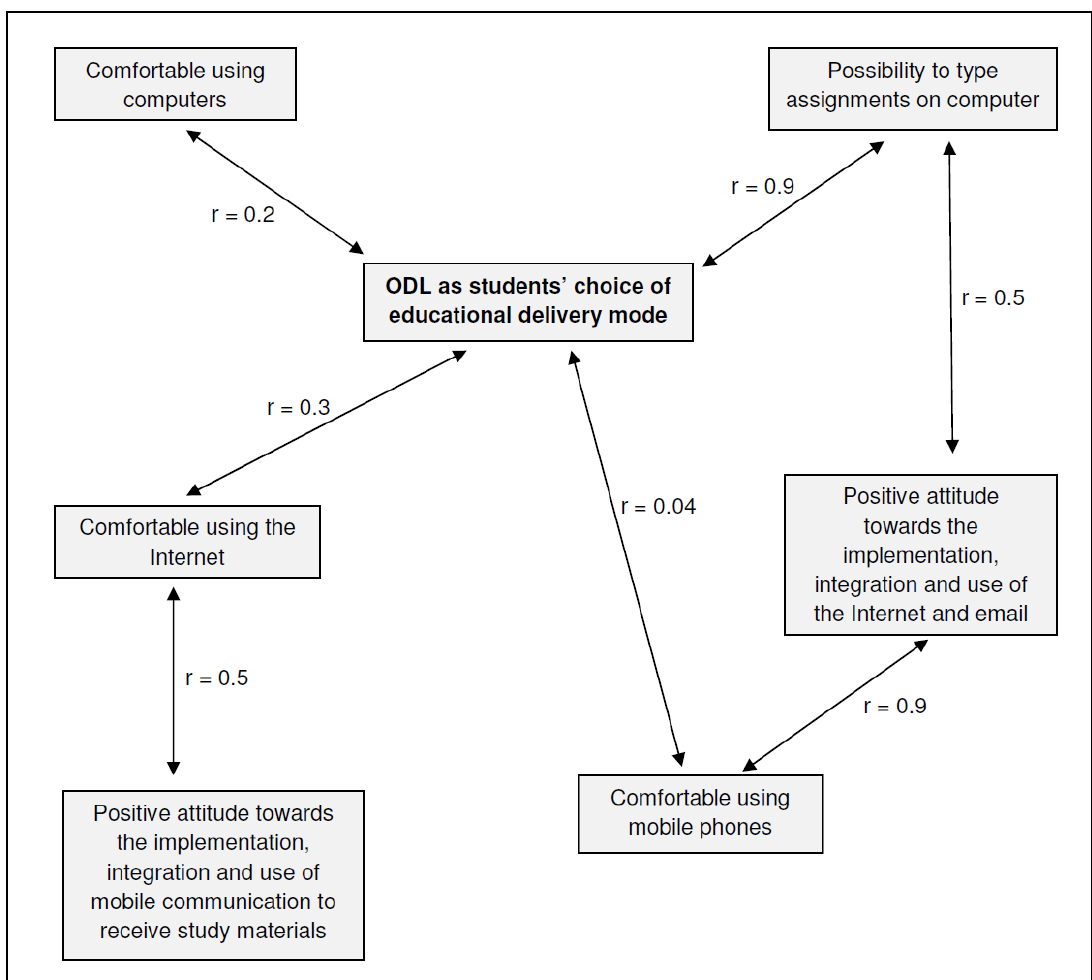
Figure 1 . Relationships (Spearman’s rank-order correlations) between ODL, as students’ choice of educational delivery mode, and aspects of their